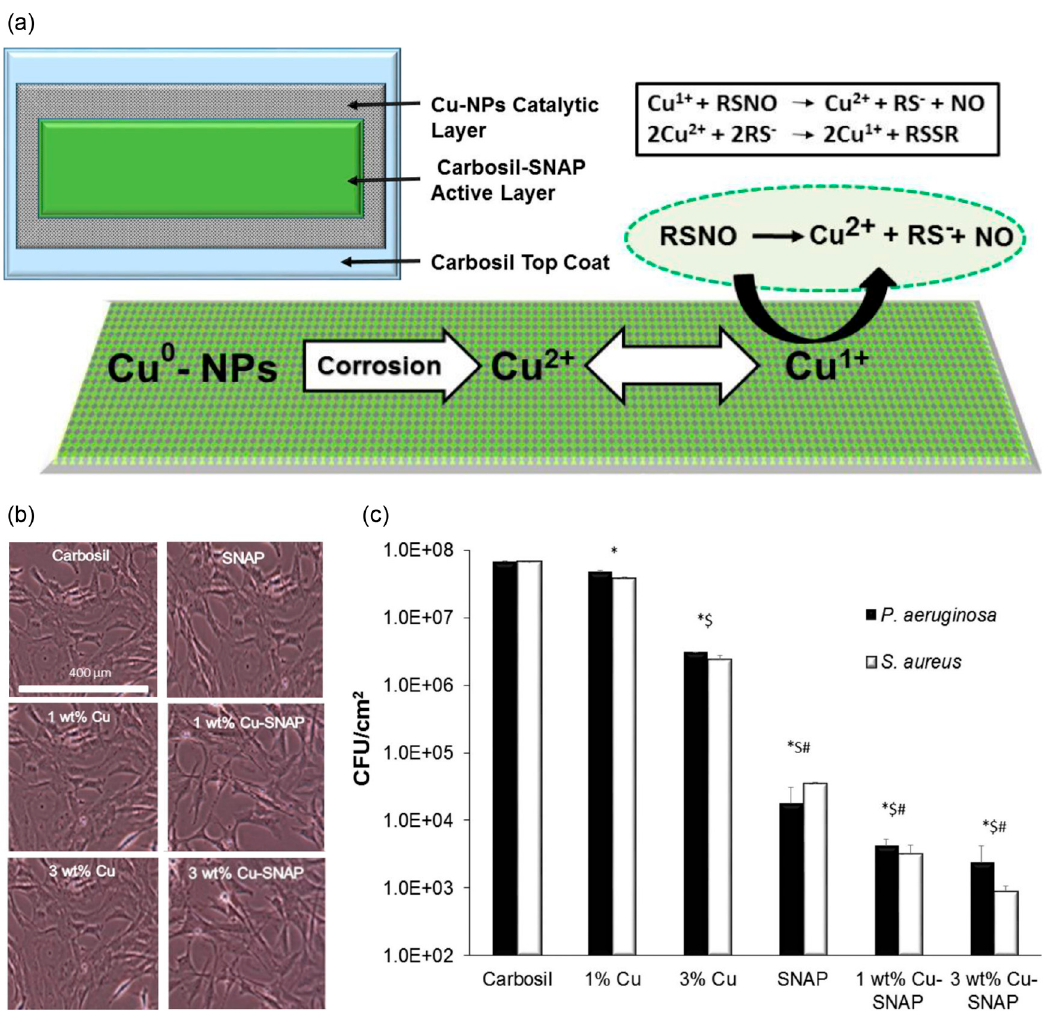
Figure 5. Structure, NO releasing mechanism, noncytotoxicity, reduced platelet adhesion, and bacterial inhibition of Cu-SNAP films. ( a ) Representative schematic of the polymeric composites with SNAP and Cu-NPs coating and the mechanism of NO releasling from SNAP and Cu-NP coating. ( b ) Optical images of 3T3 fibroblast cells after 24 h leachate treatment. ( c ) Inhibition of viable gram-negative ( P. aeruginosa ) and gram-positive ( S. aureus ) bacteria strains on the SNAP and Cu-NPs coating surface, in which *, $, and # indicate significant di ff erence in CFU / cm 2 of both bacteria compared to that of control, 1 wt % Cu, and 3 wt % Cu-Carbosil composites, respectively. Reproduced with permission from [116]. Copyright 2017, American Chemical